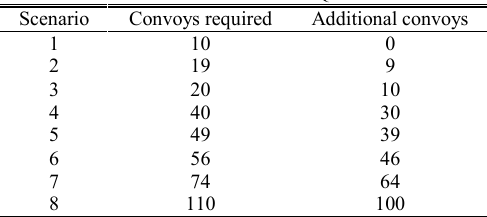
TABLE XII N UMBER OF C ONVOYS R